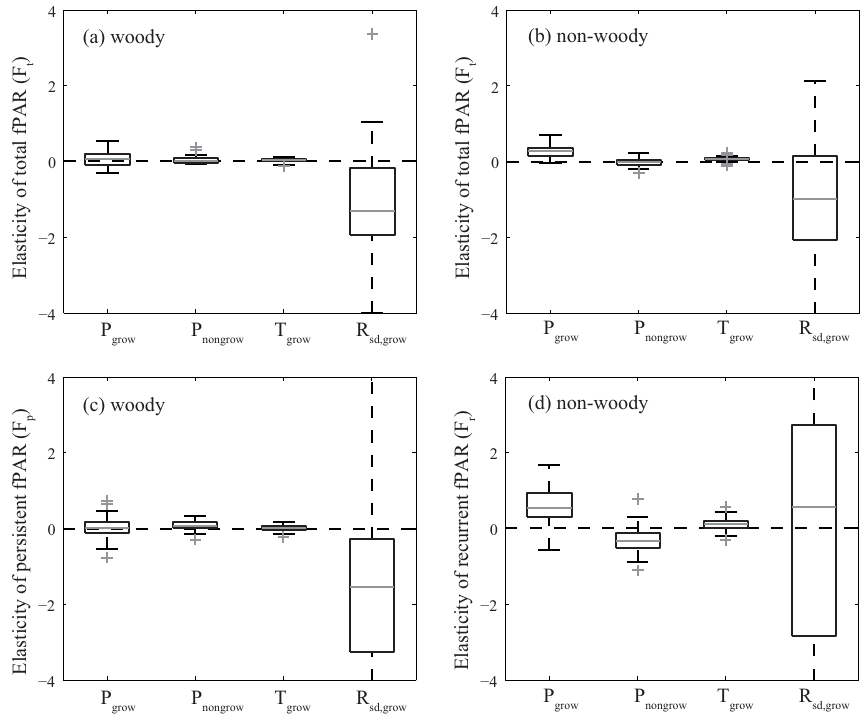
Fig. 9. The quantile map of climate elasticity parameters of (a) total fPAR for 26 woody vegetation dominated catchments (with E 0 /P < 2.0), (b) total fPAR for 48 non-woody vegetation dominated catchments (with E 0 /P ≥ 2.0), (c) persistent fPAR for 35 woody vegetation dom- inated catchments and (d) recurrent fPAR for 30 non-woody vegetation dominated catchments. Note that P grow represents precipitation during growing season, P nongrow represents precipitation during non-growing season, T grow represents mean temperature during growing season and R sd , grow represents mean incoming shortwave radiation during growing